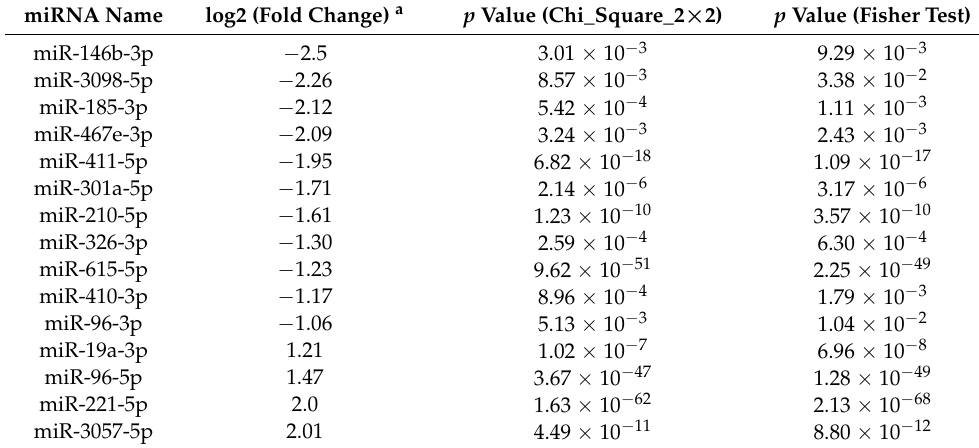
Table 1. The miRNAs associated with ZEN toxicology.